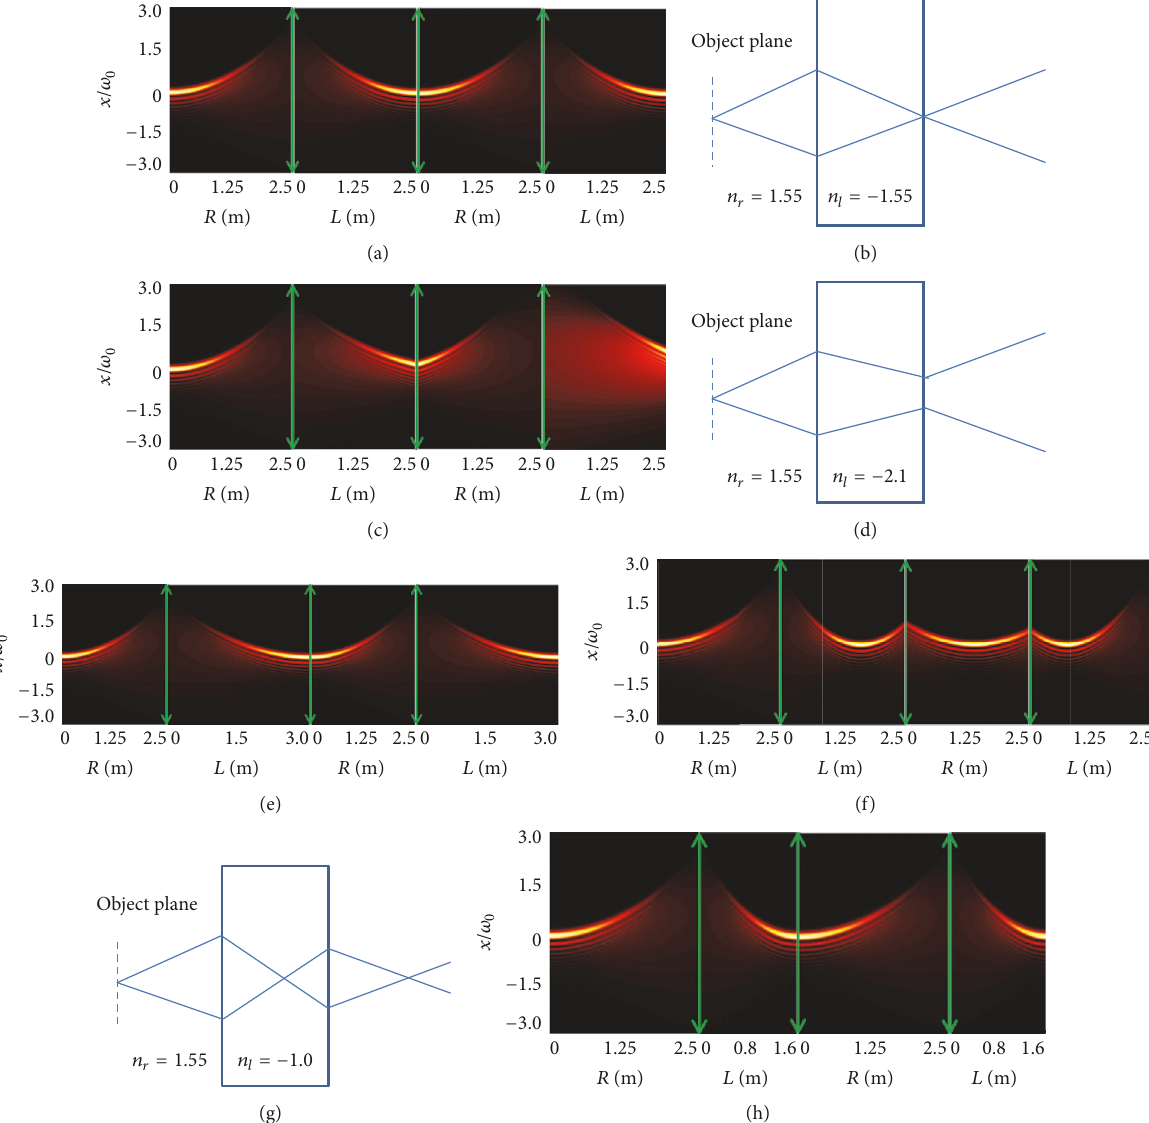
Figure 3: Side view of Airy beam propagating in each RHM and DNM unit successively with three kinds of DNMs and corresponding principle diagrams. (a) DNM’s 𝜔 𝑝𝑒 = 𝜔 𝑝𝑚 = 2𝜋 ] × √2.55 , (b) principle diagram where beam can just be compensated by each DNM,